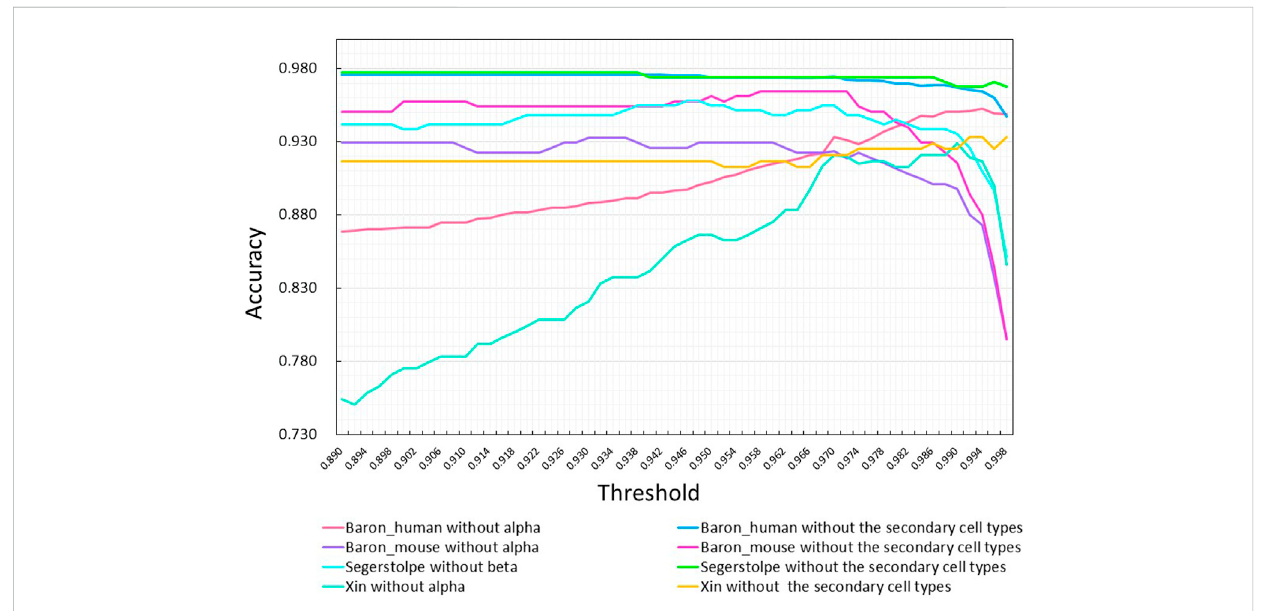
FIGURE 9 Effectofadjusting thethresholdontheaccuracyofMulCNNinpredictingdifferentda-tasets.Eachcurvecorrespondsto theremoval oftheprimary or the secondary cell types from dif-fer-ent data